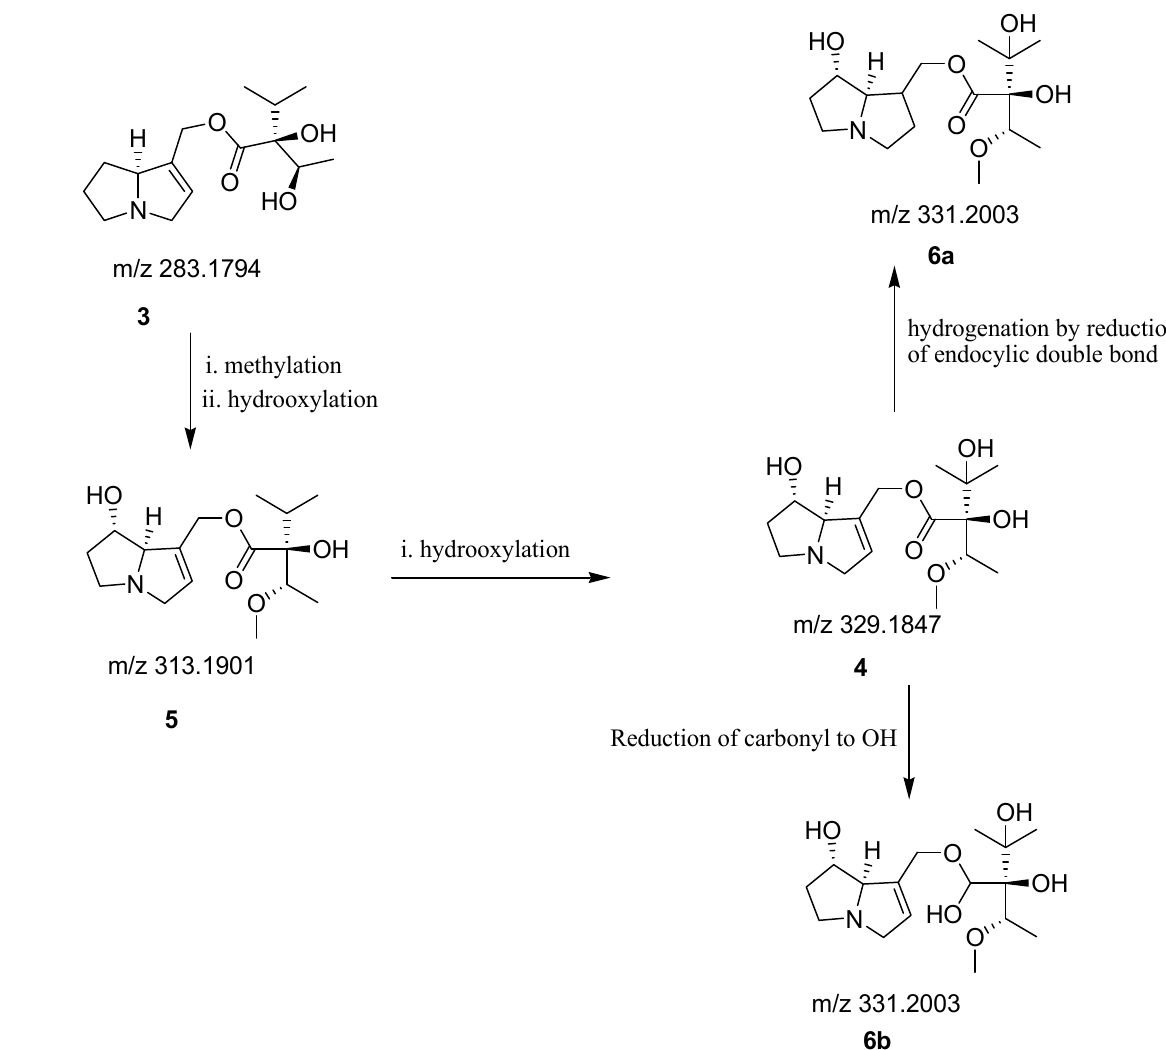
Scheme 1. The identified iridoid compound on the base of the LC-MS of the methanolic extract of H. crispum